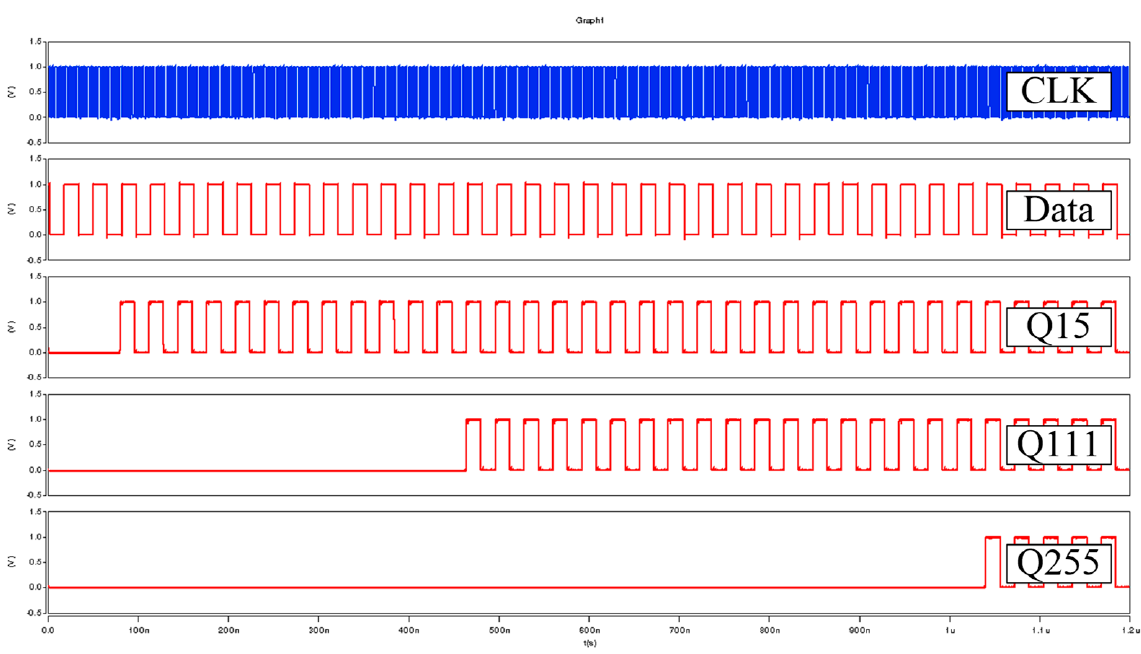
Figure 7. Post layout simulation of 256-bit shift register design based on the proposed CLSR de- sign.